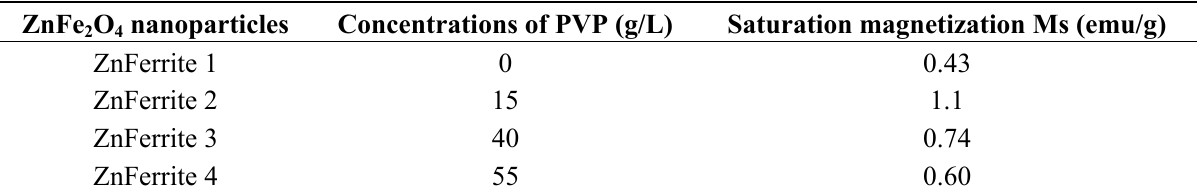
Table 2. Magnetic properties of ZnFe PVP, determined by vibrating sample magnetometer (VSM) technique at room temperature, calcined at 873